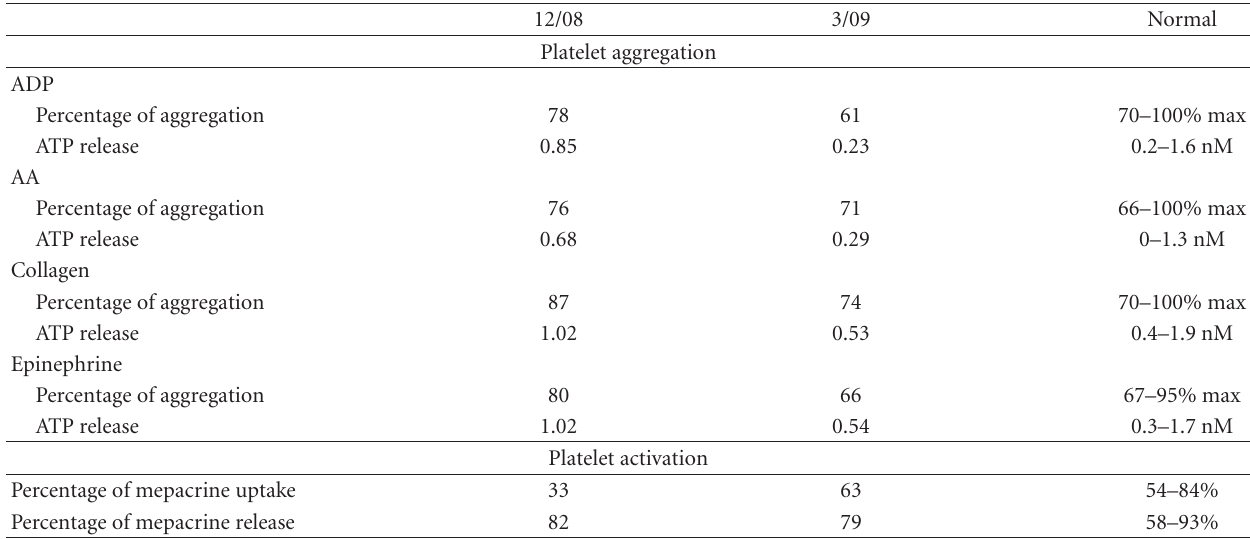
Table 1: Platelet aggregation and activation